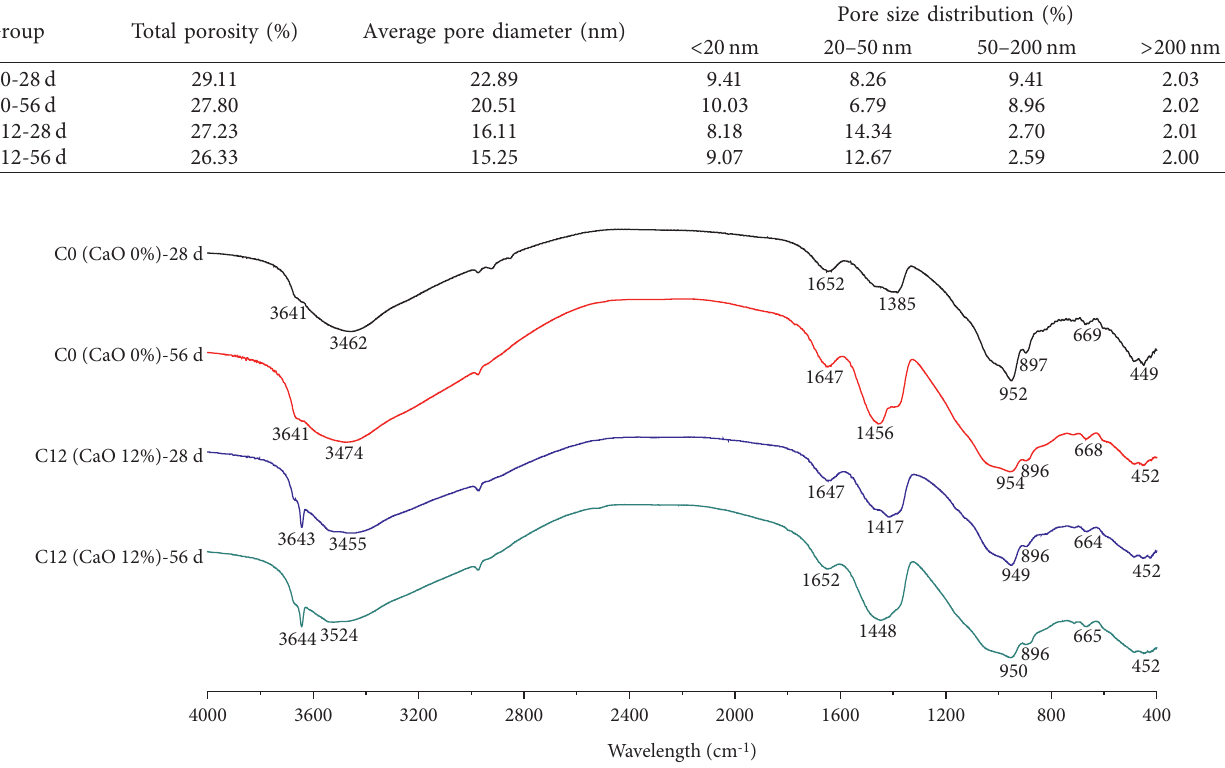
Figure 3: FTIR spectra of C0 and C12 at 28 d and